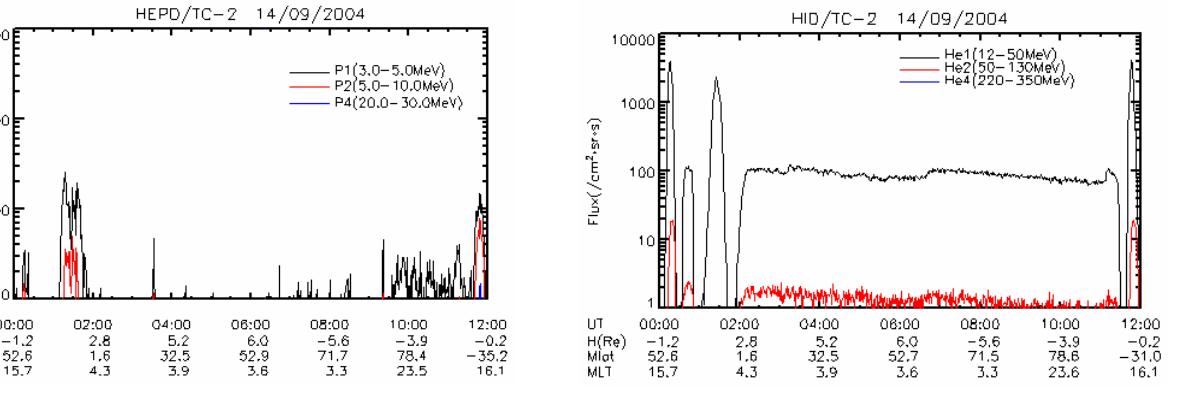
Fig. 16. The minute-averaged high energy proton flux in energy channels P1, P2 and P4 on 14 September 2004.